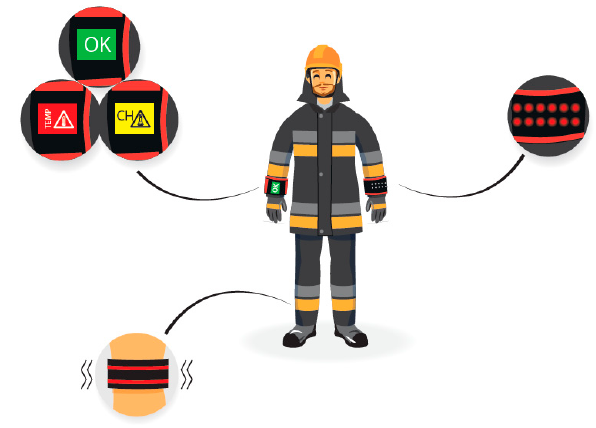
Figure 1. A scheme of location of PWS during the utility tests.